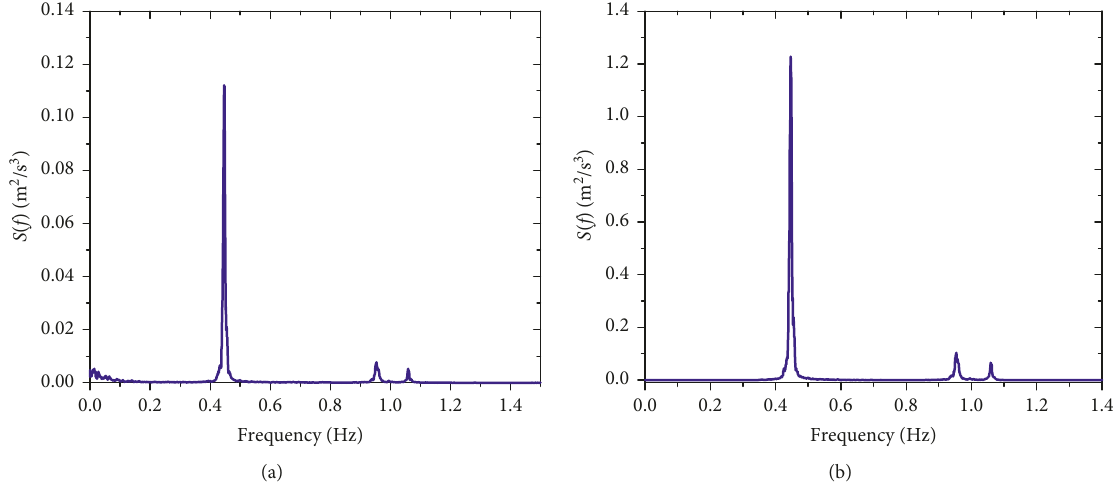
Figure 14: Power spectrum densities of acceleration responses. (a) Vertical direction. (b) Lateral